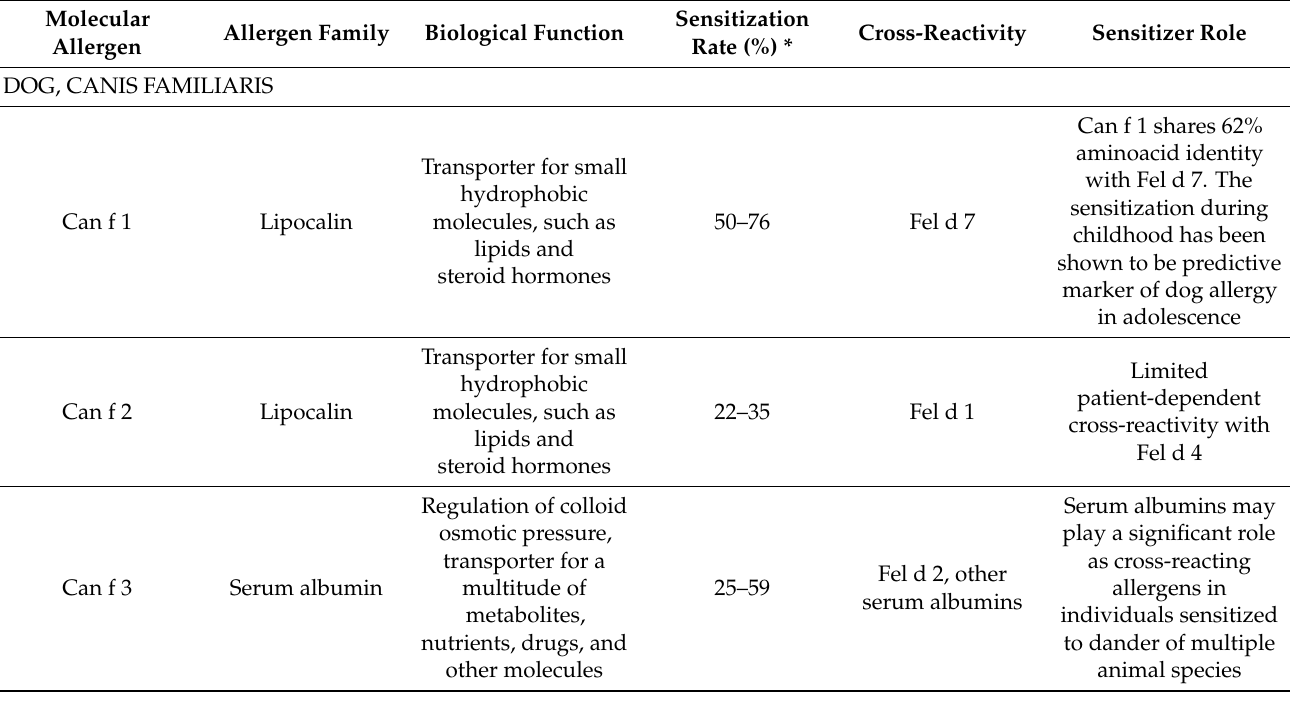
Table 1. Major and minor dog and cat allergens. Can f, canis familiaris; Equ c, equus caballus; Fel